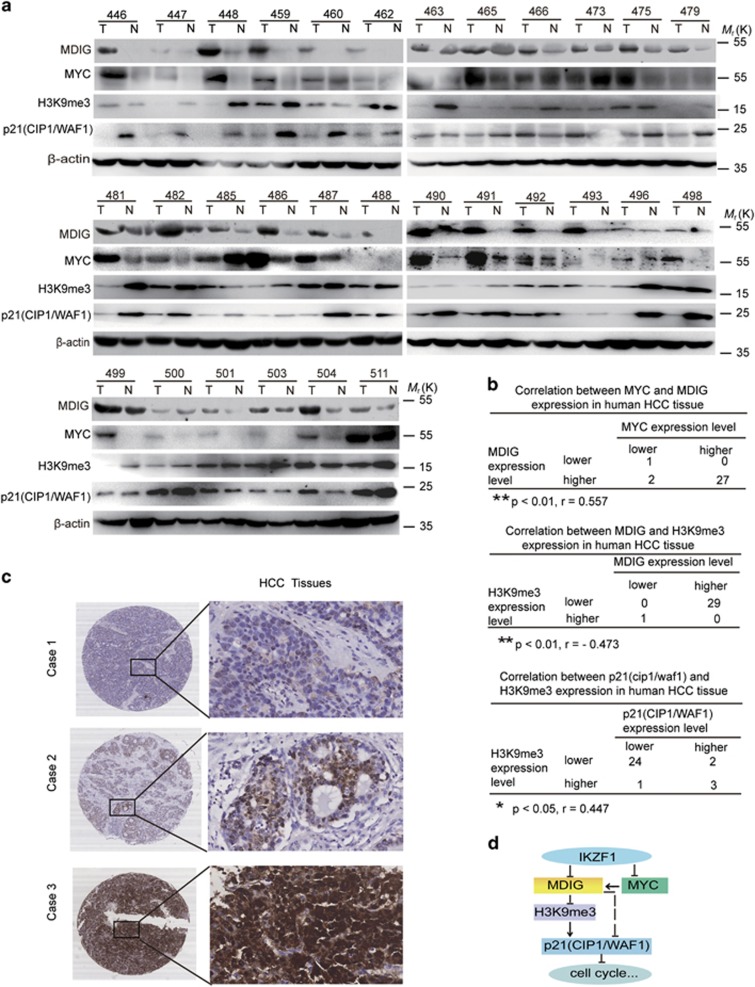
Higher expression levels of MDIG with HCC patients. (a) Analysis of MDIG, MYC, H3K9me3 and p21(CIP1/WAF1) expression in human primary HCC and adjacent non-cancerous tissues by western blot. T, HCC tissue; N, matched adjacent non-cancerous liver tissue. β-actin was used as an internal loading control. (b) Several correlation analyses of MDIG, MYC, H3K9me3 and p21(CIP1/WAF1) protein levels in 30 human primary HCC and matched adjacent non-cancerous liver tissues were presented. Pearson’s chi squared test was used; r, correlation coefficient. (c) IHC analysis of MDIG protein in HCC samples. Cases 1, 2 and 3, respectively, represent MDIG protein weakly, moderately and strongly stained in HCC tissues; original magnification for right panel: × 400). (d) The regulation model of MDIG in HCC. MDIG is regulated by IKZF1 and MYC; MDIG is able to downregulate the expression level of H3K9me3, which is bound to the transcribed regions of p21(CIP1/WAF1), and further activated it. *P<0.05, **P<0.01, ***P<0.001